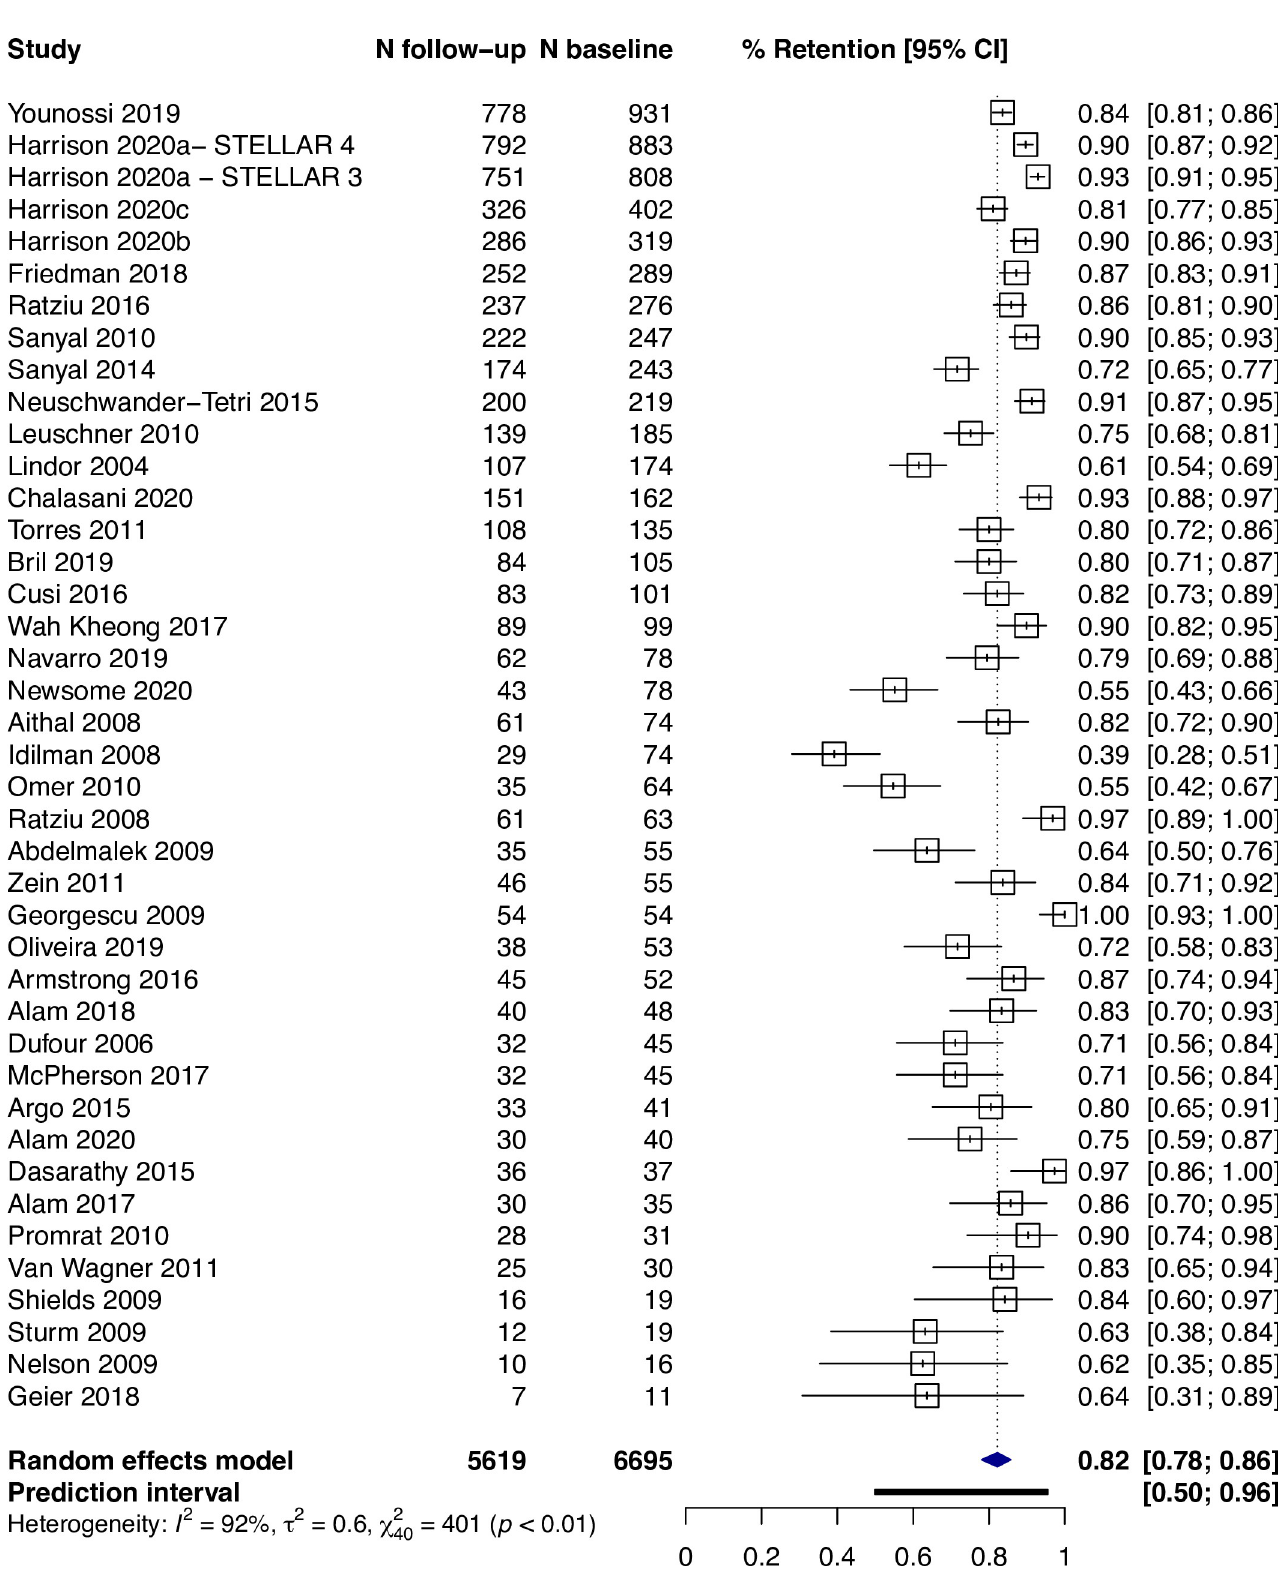
Fig 2. Proportion of participants (95% CI) with a valid follow-up biopsy.